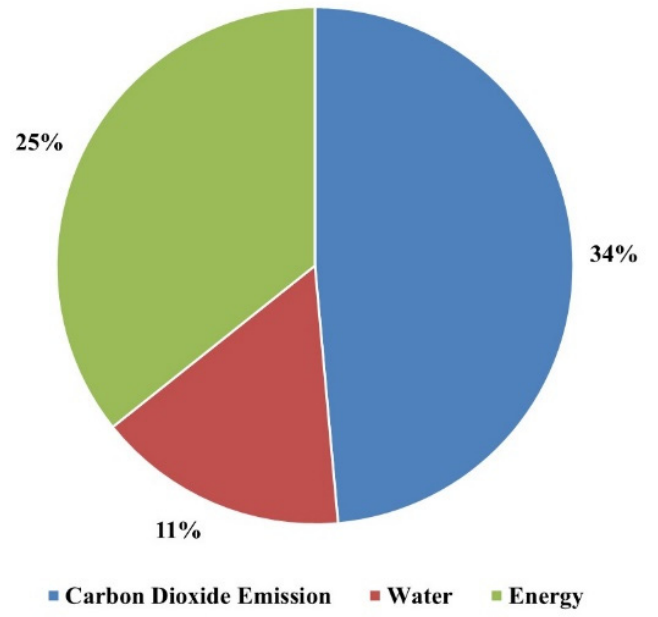
Figure 2. Effect of GB on various parameters [2] and remaining 30% others.